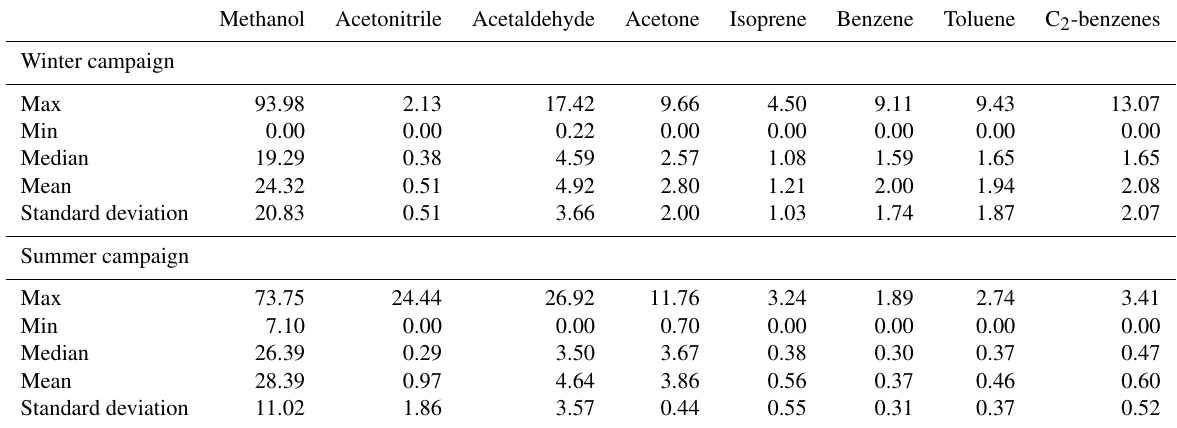
Figure 4. The campaign mean flux footprint climatologies for the winter (left) and summer (right) field campaigns. The IAP meteorological tower is represented by the red dot and the surrounding 100 × 100m cells are coloured by their mean contribution to the flux. The contour lines correspond to the distances from the tower where the surface contributions to the measured fluxes cumulate to 30%, 60% and 90%, respectively. Table 1. Summary of VOC mixing ratio for the dominant VOCs observed in Beijing during the APHH-Beijing winter and summer campaigns (in ppbv). Methanol Acetonitrile Acetaldehyde Acetone